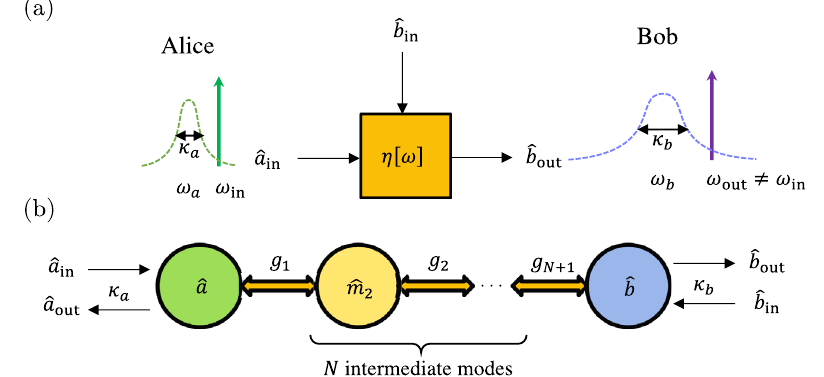
Fig. 1| Genericmodelofquantum transducers.a Aquantumtransducerthatcan faithfully convert quantum states between different input and output frequencies ω ω in and out (in the lab frame), which is modeled as a thermal-loss channel with